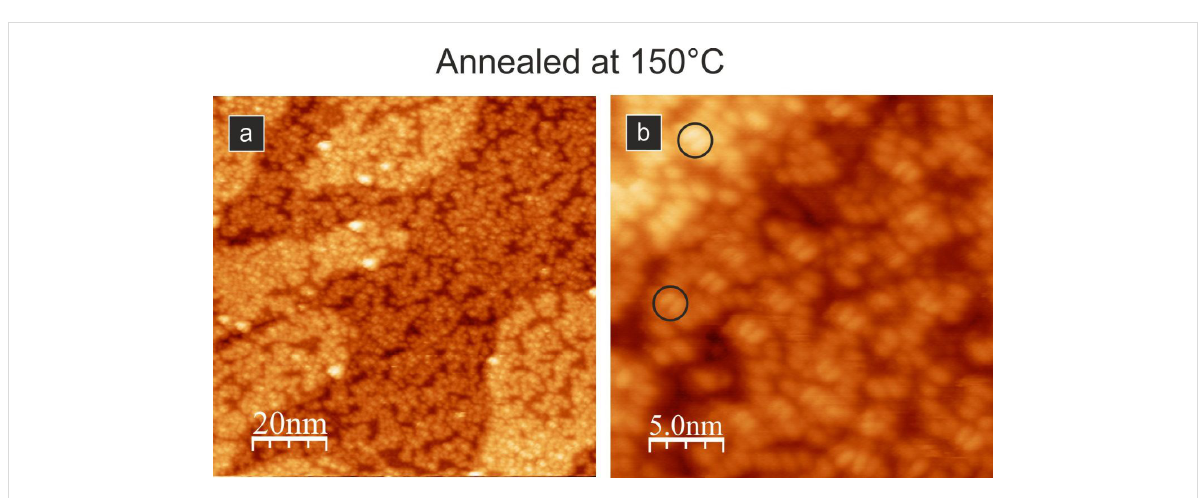
Figure 7: Empty-state STM images of the closed layer of PTCDA molecules after annealing to 150 °C: (a) 100 nm × 100 nm scan and (b) 25 nm × 25 nm scan. The layer is completely disordered, and the black circles in (b) indicate single molecules exhibiting typical two-lobe contrast. All images acquired with 2 pA tunnelling current and 2.0 V bias